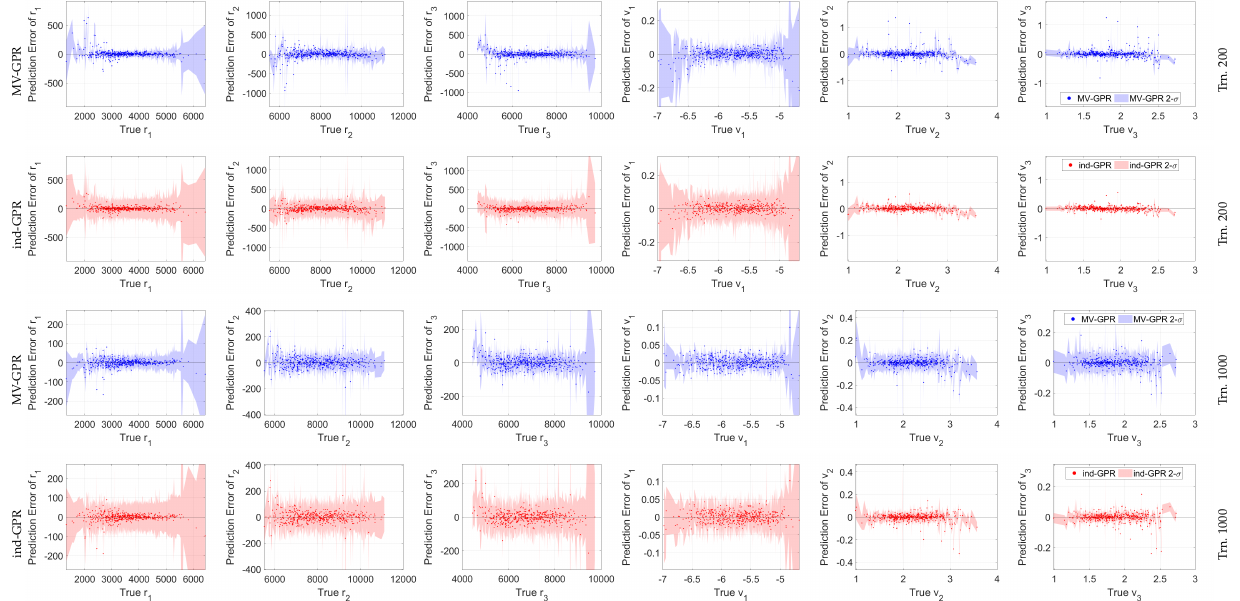
Figure 10. Cartesian state versus the GPR output error with accompanying 3- σ bounds for a 500 point random sub-sample of the 5000 test orbits. Note the differing y -scale between the training levels.